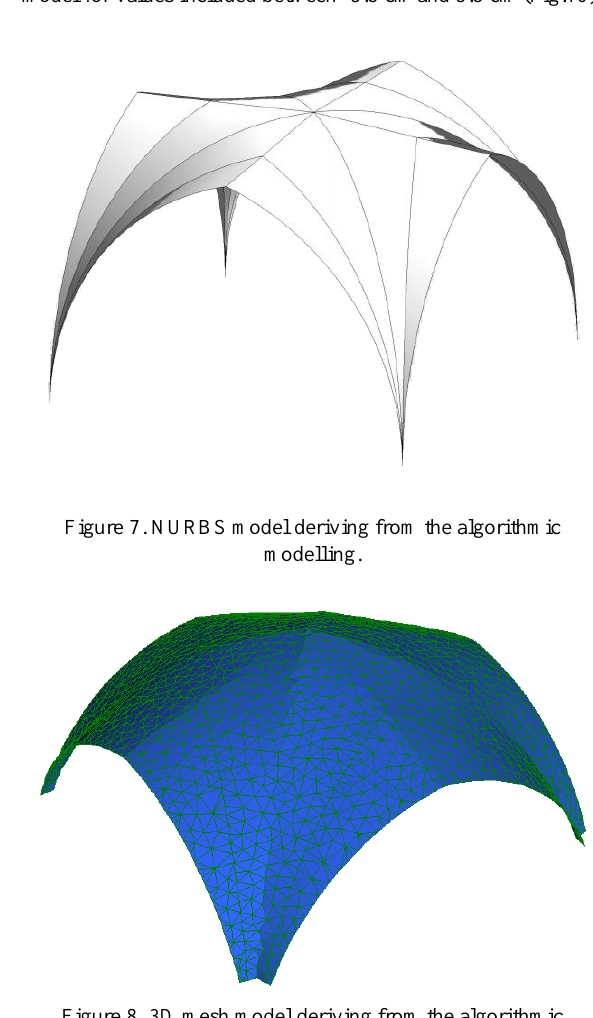
Figure 8. 3D mesh model deriving from the algorithmic modelling.